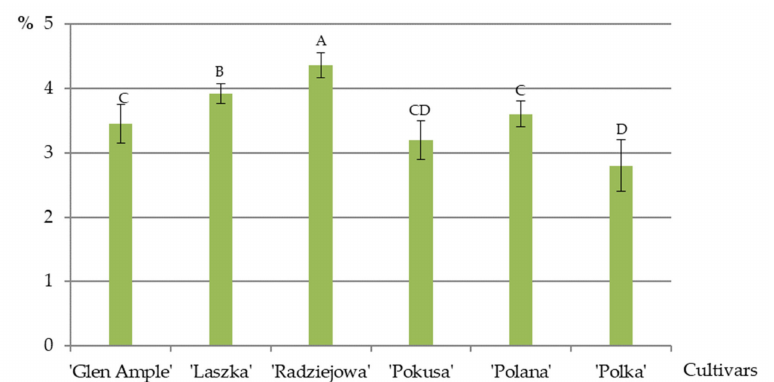
Figure 11. Average total fat content in pollen grains of R. idaeus cultivars. Explanations: means followed by the same letter do not differ between the cultivars at a significance level α = 0.05; (number of repetitions n = 3). Bars indicate standard